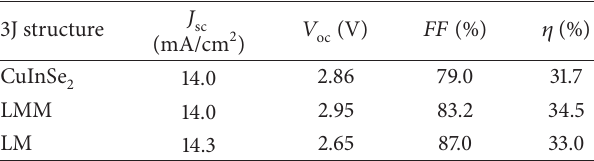
Table 2: Simulated current-voltage metrics of the 3Js of interest under 1000 W/m 2 and at 300 K with TDD 10 6 cm − 2